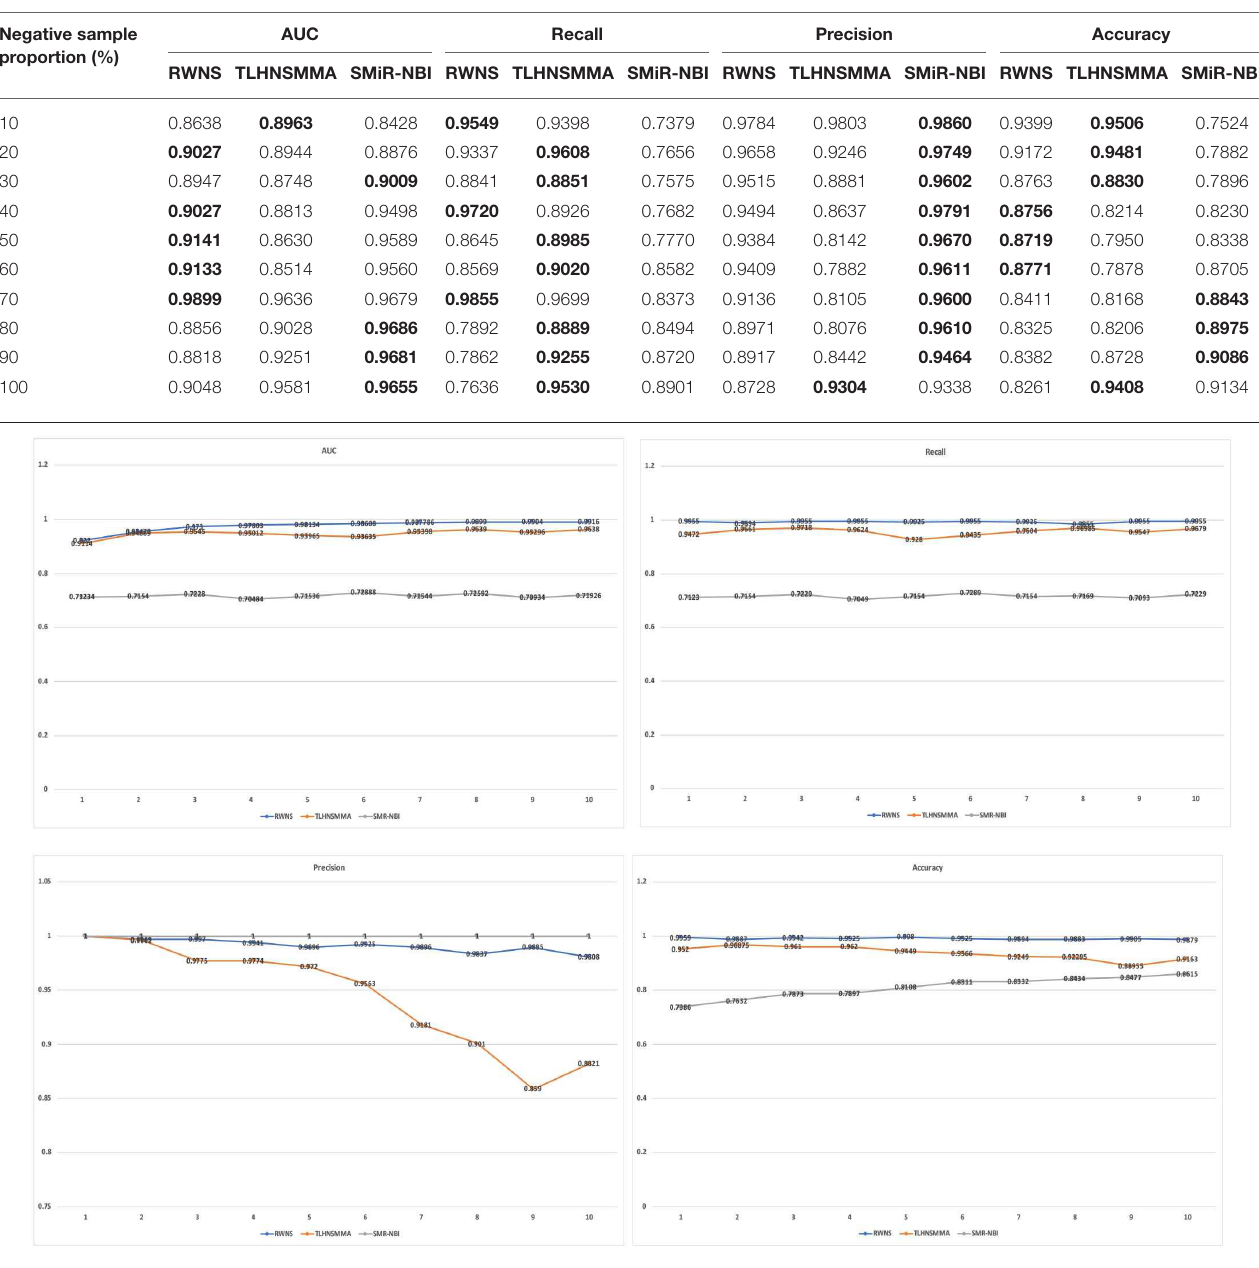
FIGURE 5 | The performance comparison of RWNS, TLHNSMMA, and SMiR-NBI under 5-fold cross validation on SM2miR1.